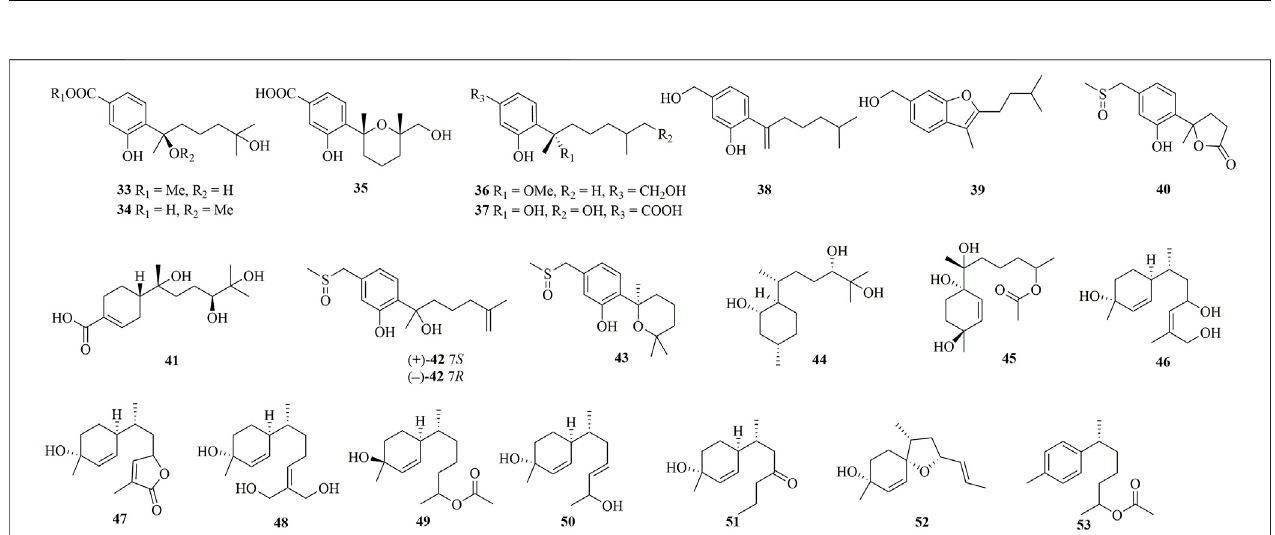
Frontiers in Chemistry |